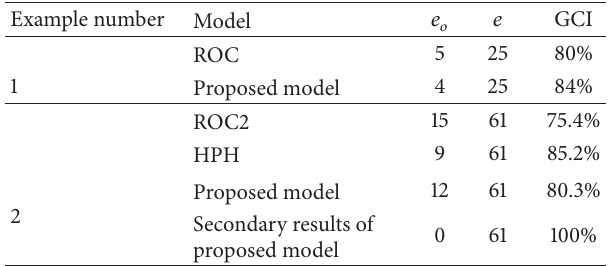
Bracketed numbers show the number of corresponding machine assigned to each cell. Table11:CFresultsoftheproposedmodelversustheresultsofother